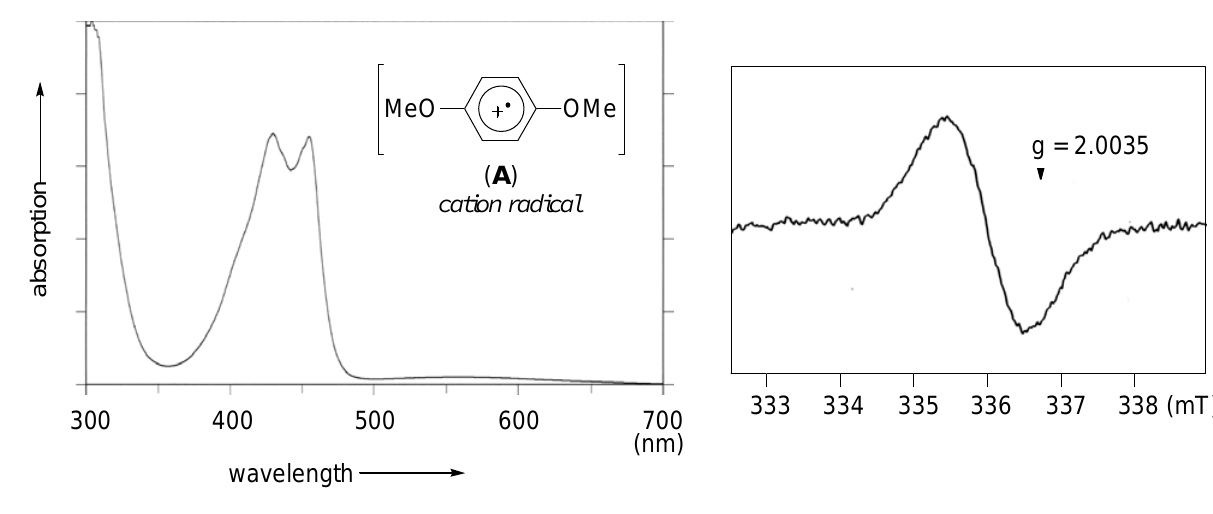
Figure 2. UV-VIS and ESR spectrums for the mixture of 1,4-dimethoxybenzene and HTIB ) CHOH at room in (CF 3 2